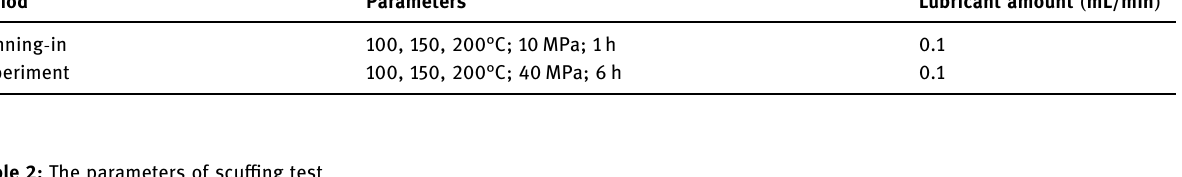
Table 2: The parameters of scu ffi ng test Period Parameters Low load running - in High load running -